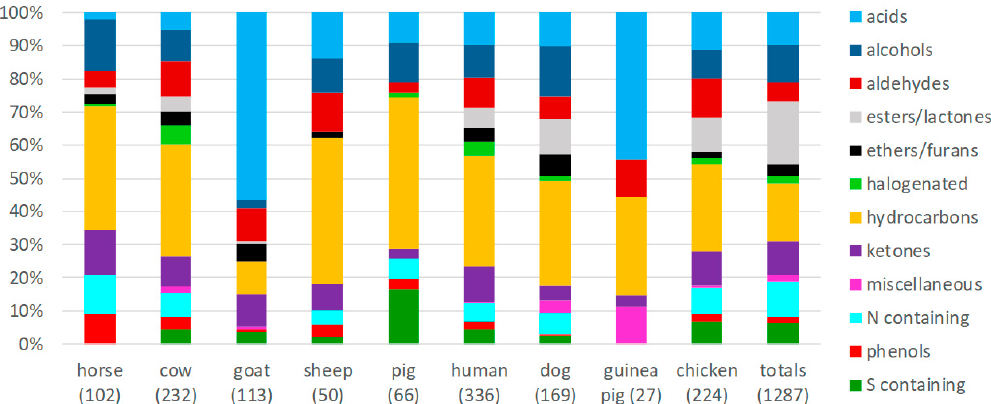
Figure 1. Relative proportion of volatile organic compounds (VOCs) in different chemical classes that have been documented from domestic animal emissions, and across all species reviewed. Numbers in parentheses are the total number of unique compounds reported for the species. Percentages indicate the relative abundance of chemical entities described in each compound class, not their relative concentrations.